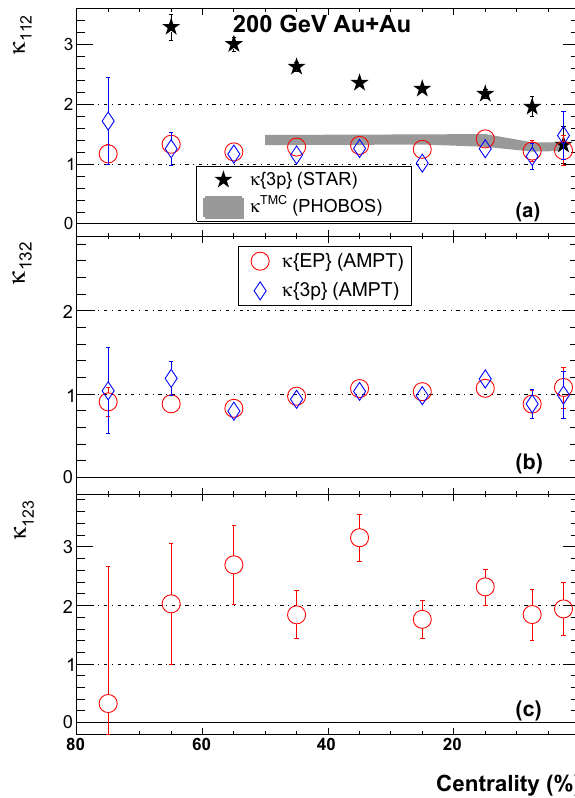
√ s NN = 200 GeV. The